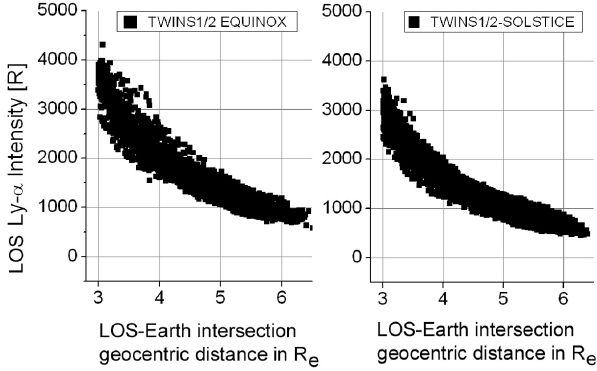
Fig. 5. TWINS1/2 equinox dataset (left) and summer-solstice dataset (right) LAD1/2 Lyman- α all lines of sight (LOS) intensi- ties in Rayleigh [R] (recalibrated as described in Sect. 9 and in- terplanetary background corrected) plotted against their geocentric LOS–Earth intersection distances in R E .